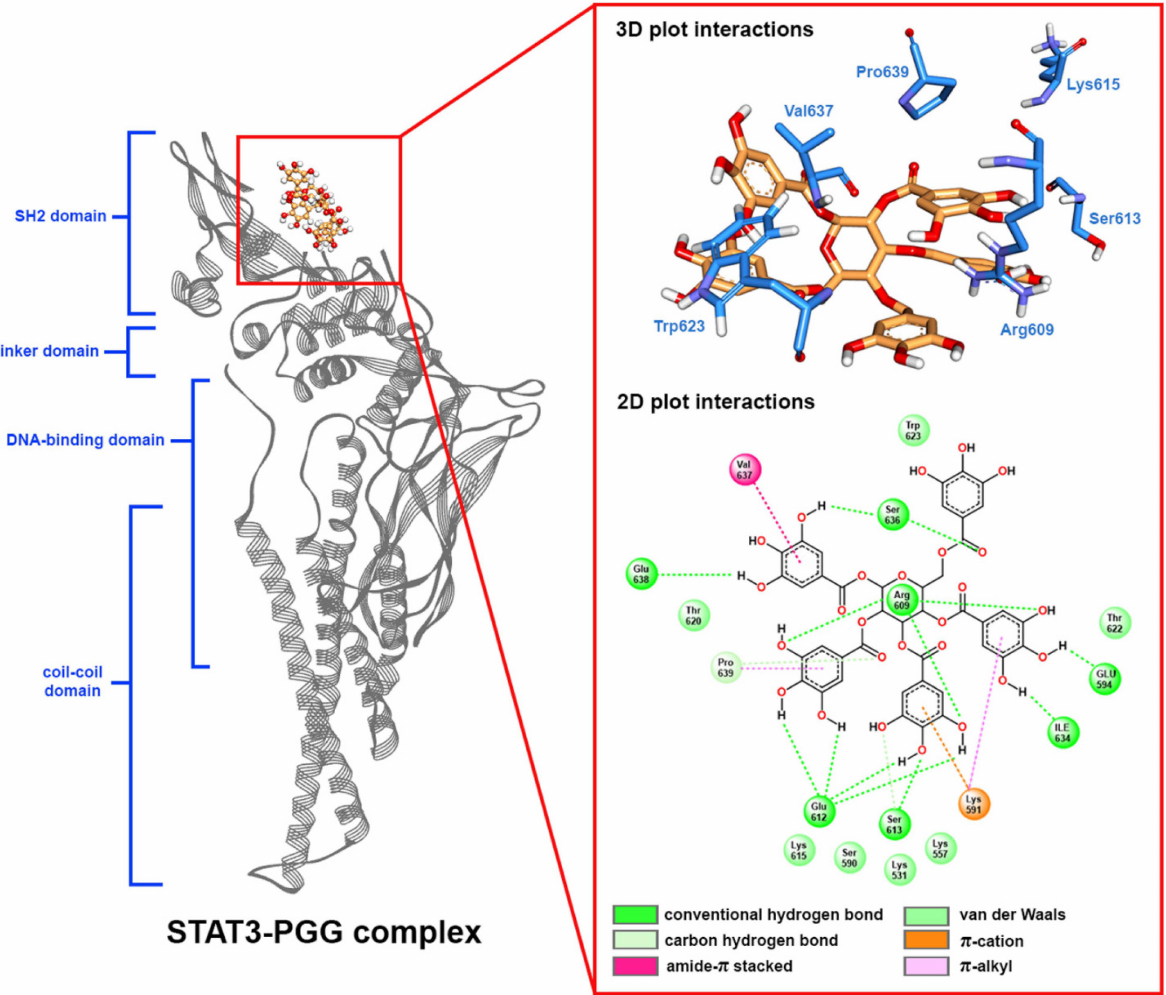
Figure 7. The predicted binding mode in 2-dimension (2D) and 3-dimension (3D) formats of PGG at the binding pocket of STAT3 was obtained from the last frame of the 50 ns molecular dynamic